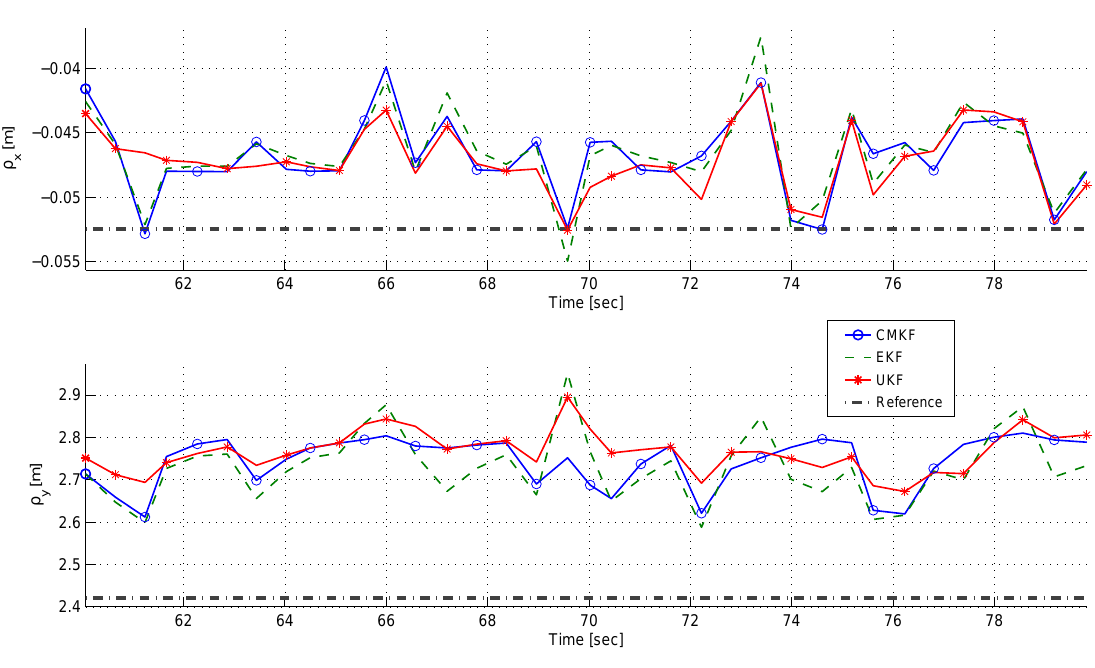
Figure 13. A comparison of ρ x ( top ) and ρ y ( bottom ) estimation using different filters in the static